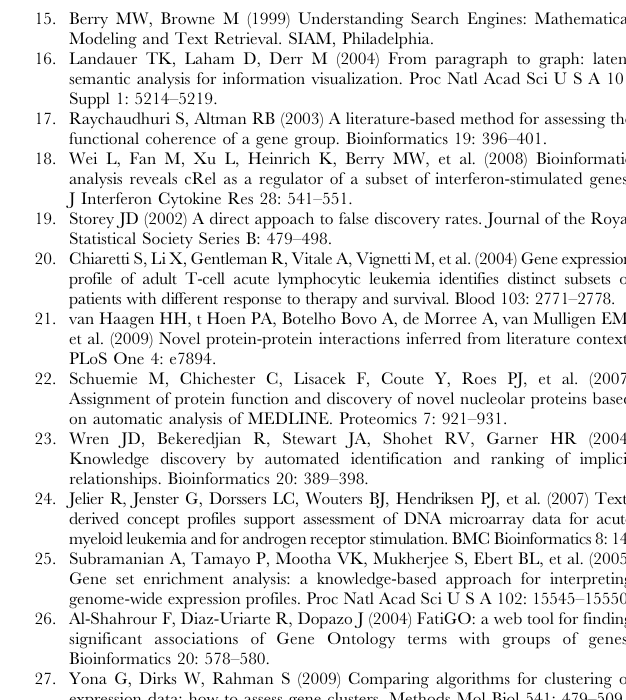
Figure S1 Venn Diagram of differentially expressed genes (DEGs) generated by three different statistical tests on four different microarray datasets: ALL1 (A), ALL2 (B), ALL3 (C) and ALL4 (D).